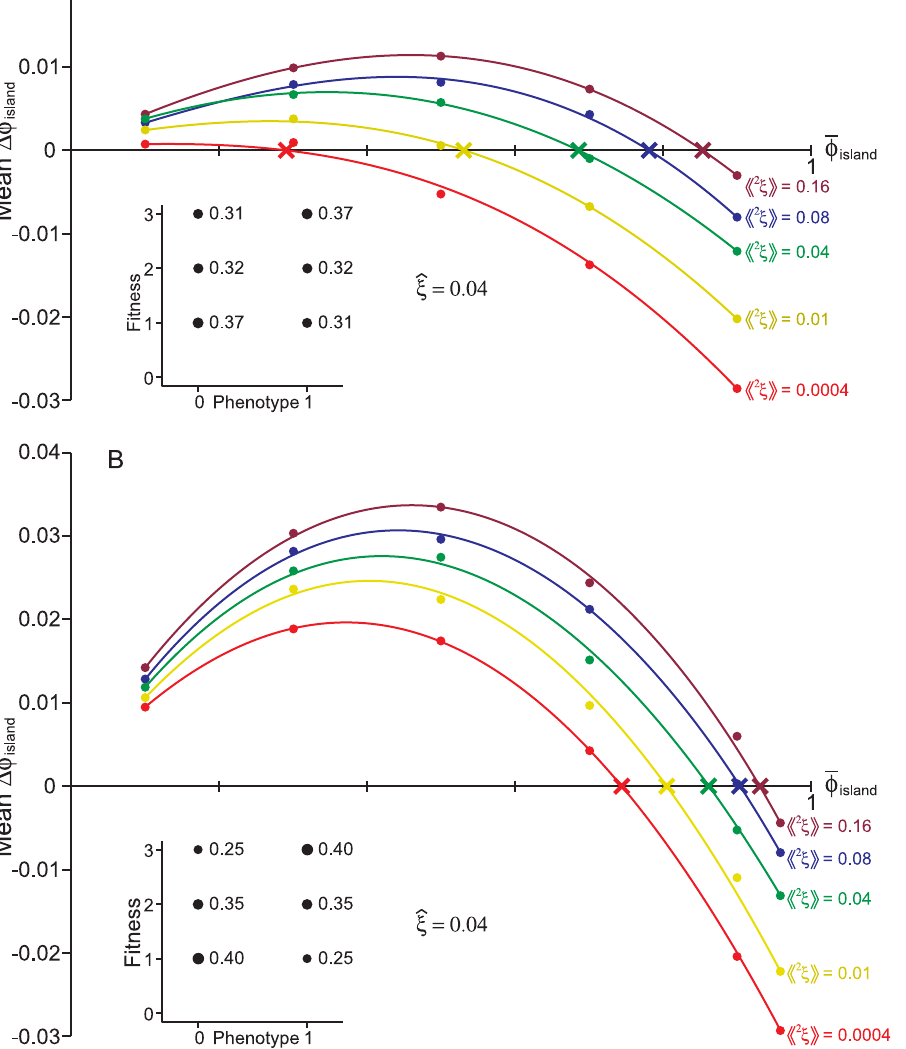
Figure 3. The relation between variance in immigration, SS 2 j TT , selection, and c D w D w in an island-continent model. The colored lines represent c D w D w on the island as a function of current mean island phenotype for different variances in immigration rate (each colored dot represents the mean of 10,000 runs of an individual based simulation). Selection on the island favors w ~ 1 (inset figures). w immigrant ~ 0 , b jj ~ 0 : 04 , and N ~ 50 . Colored ‘‘ | ’’ symbols mark the values of mean island phenotype at which c D w D w ~ 0 . A) Relatively weak selection on the island. B) Stronger selection on the